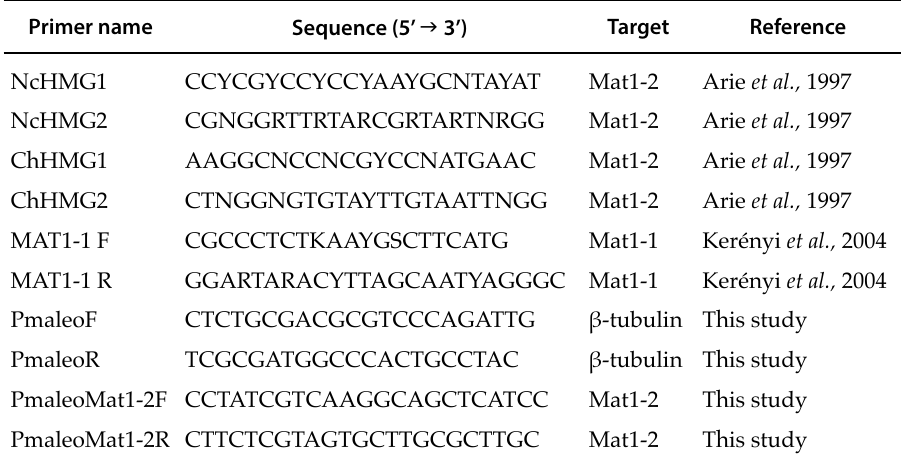
Table 2. Primers used to develop a multiplex PCR method for molecular identification and determination of mating type alleles in Togninia minima